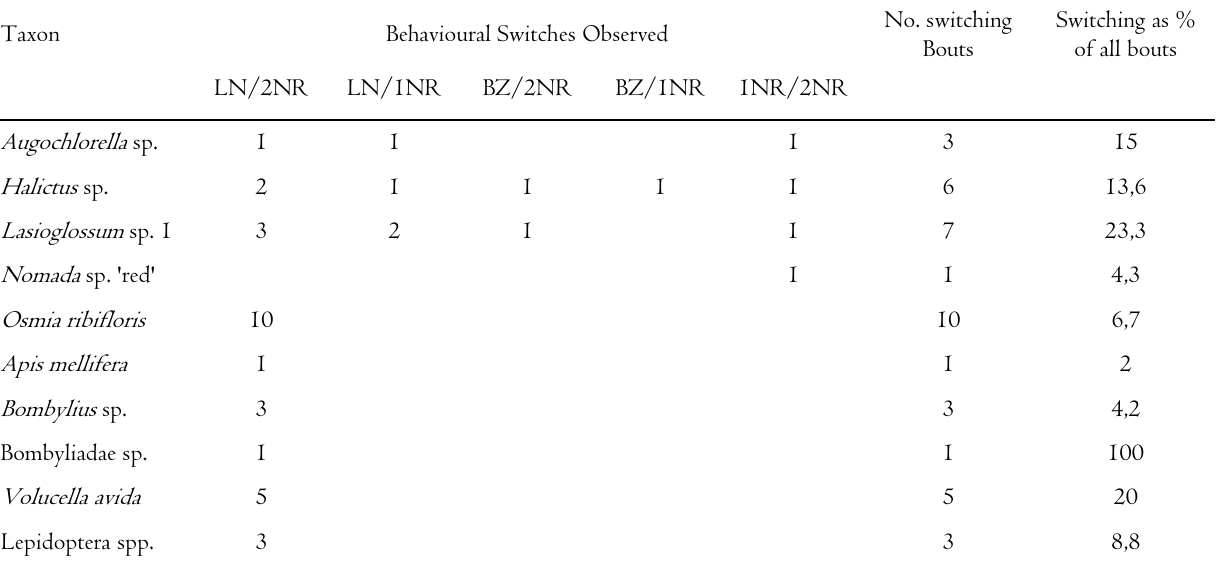
T ABLE 3. Switches in foraging behaviours during a bout by the most common floral visitors observed to switch. An "X" indicates that a species was observed to switch between that pair of behaviours during at least 1 bout. The total number of bouts during which a species switched behaviours is given, followed by the percentage of all bouts in which behavioural shifts were observed. Abbreviations: LN = legitimate nectar collection; LP = legitimate pollen collection; BZ = buzz pollination; 1NR = primary nectar robbing; 2NR = secondary nectar robbing; NT = nectar